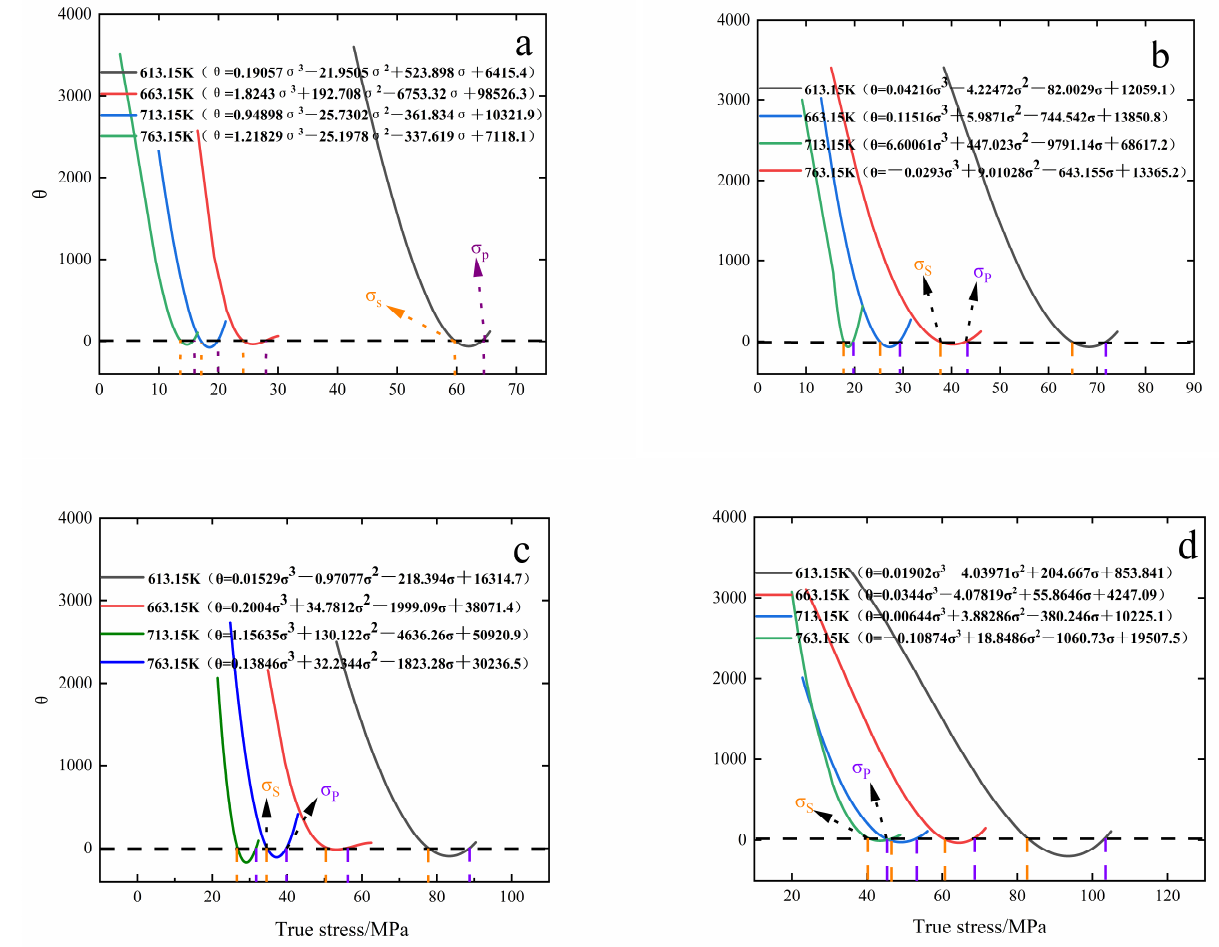
Figure 6. θ − σ curves at different strain rates. ( a ) 0.01 S − 1 .; ( b ) 0.1 S − 1 ; ( c ) 1 S − 1 ; ( d ) 10 S − 1 .